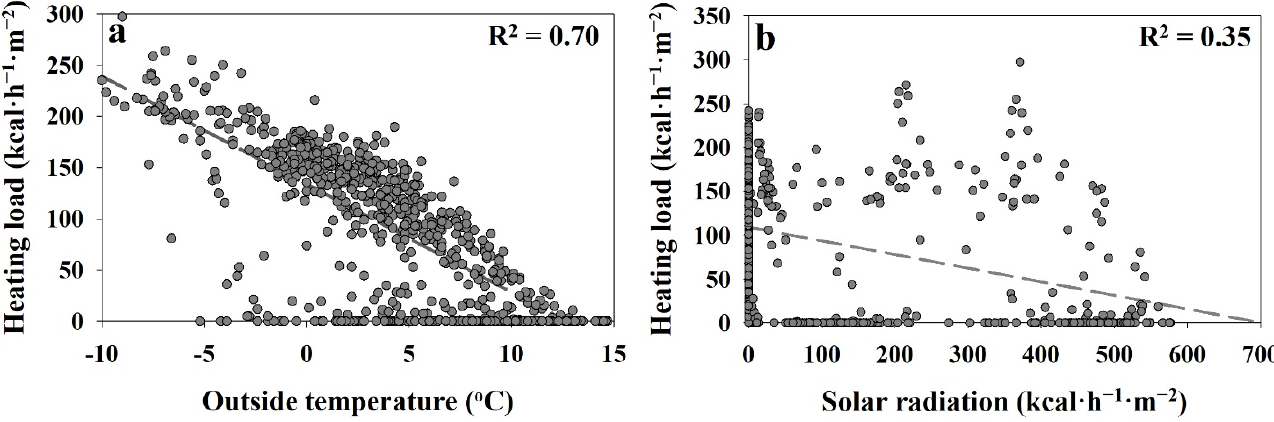
Figure 12. Linear regression analyses of monthly heating load vs. ( a ) ambient temperature and ( b ) solar radiation .